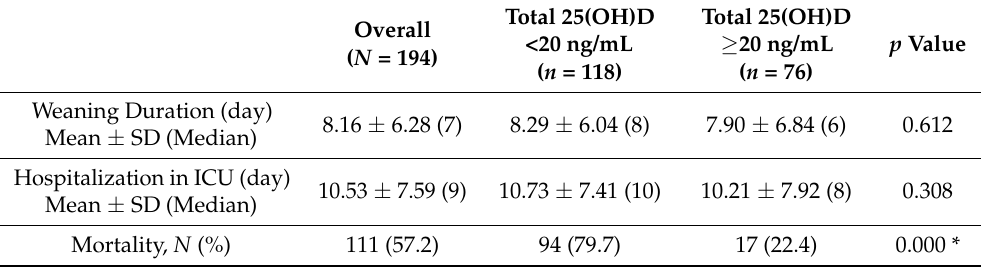
Table 5. Comparison of the prognosis of all COVID-19 patients according to the vitamin D status.